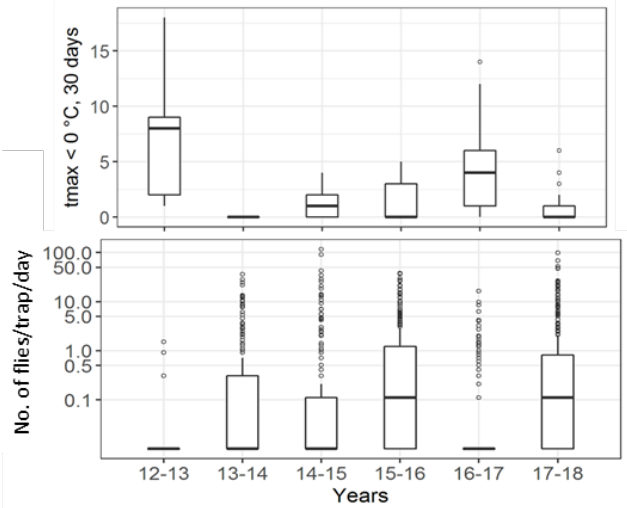
Figure 7. Winter captures: (top) the number of days when tmax < 0 °C in the 30 days before the trap content collection for each trap deployment, (bottom) captures/day from each trap deployment. Both panels are per D. suzukii -year. Note: log-scaled y-axis on the bottom panel.